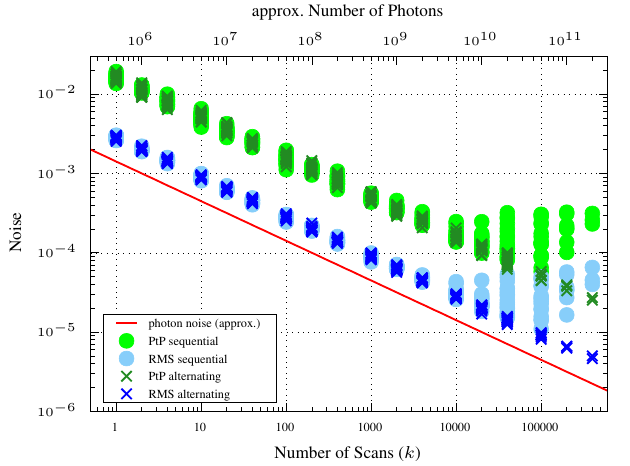
Figure 10. Results from a noise test of the HAIDI system plotted on a double-logarithmic scale. Scans with an integration time of 40ms were co-added to get a larger number of photons (approxi- mated values). The resulting noise is given as RMS and peak-to- peak (PtP) value. For comparison also the pure photon noise (red curve) is plotted, which is given by the square root of the number of photons and represents the lowest achievable noise. The evalua- tion of the data was done in the wavelength region between 350 and 400nm.